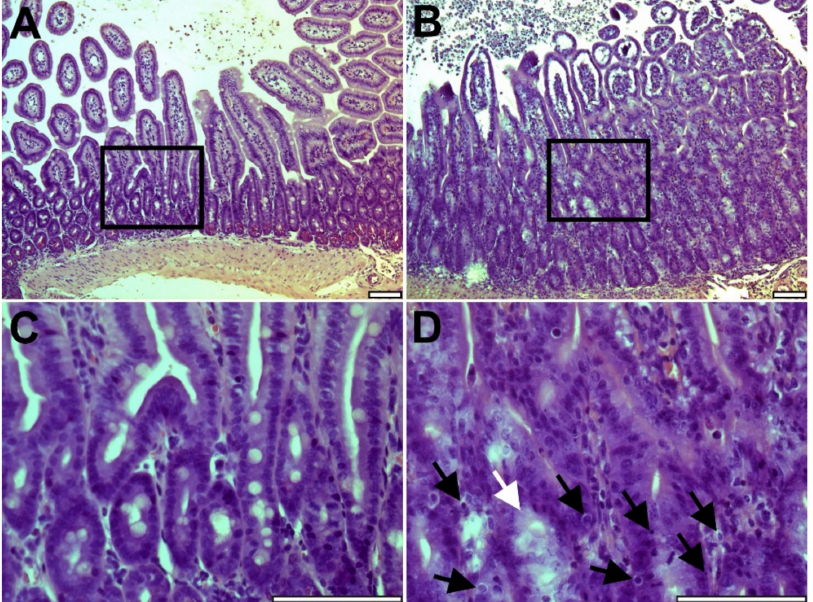
Figure 1. Histology of the intestinal allografts three days ( A , C ) and six days after transplantation ( B , D ) at low (100 × ) and high (400 × ) magnification showing essentially normal histology after three days and moderate acute rejection six days after transplantation with swollen villi, lymphocytic infiltration of lamina propria, crypt apoptosis (black arrows), and focal crypt destruction (white arrow). Scale bar = 100 µ